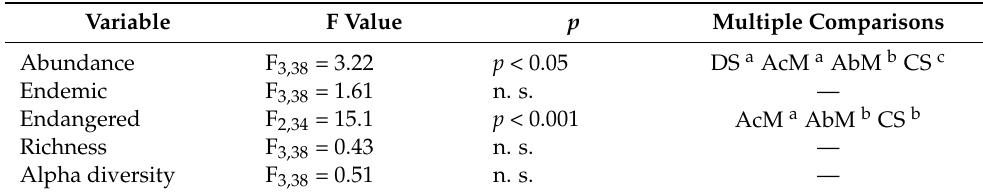
Table A5. Results of one-way ANOVA (location) and multiple comparisons with Tukey’s test of fish richness, abundance, and alpha diversity (CS, control sites; AcM, active mines; AbM, abandoned mines; DS, downstream sites; n. s., not significant). There are no significant differences between locations with the same